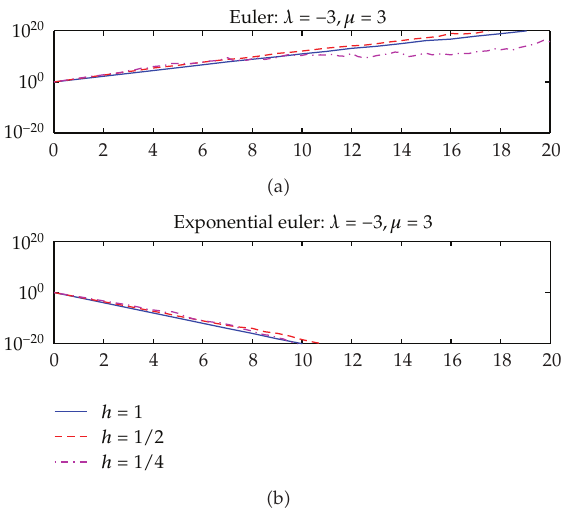
Figure 3: The numerical solutions with λ (cid:8) − 3 ,μ (cid:8) 3.